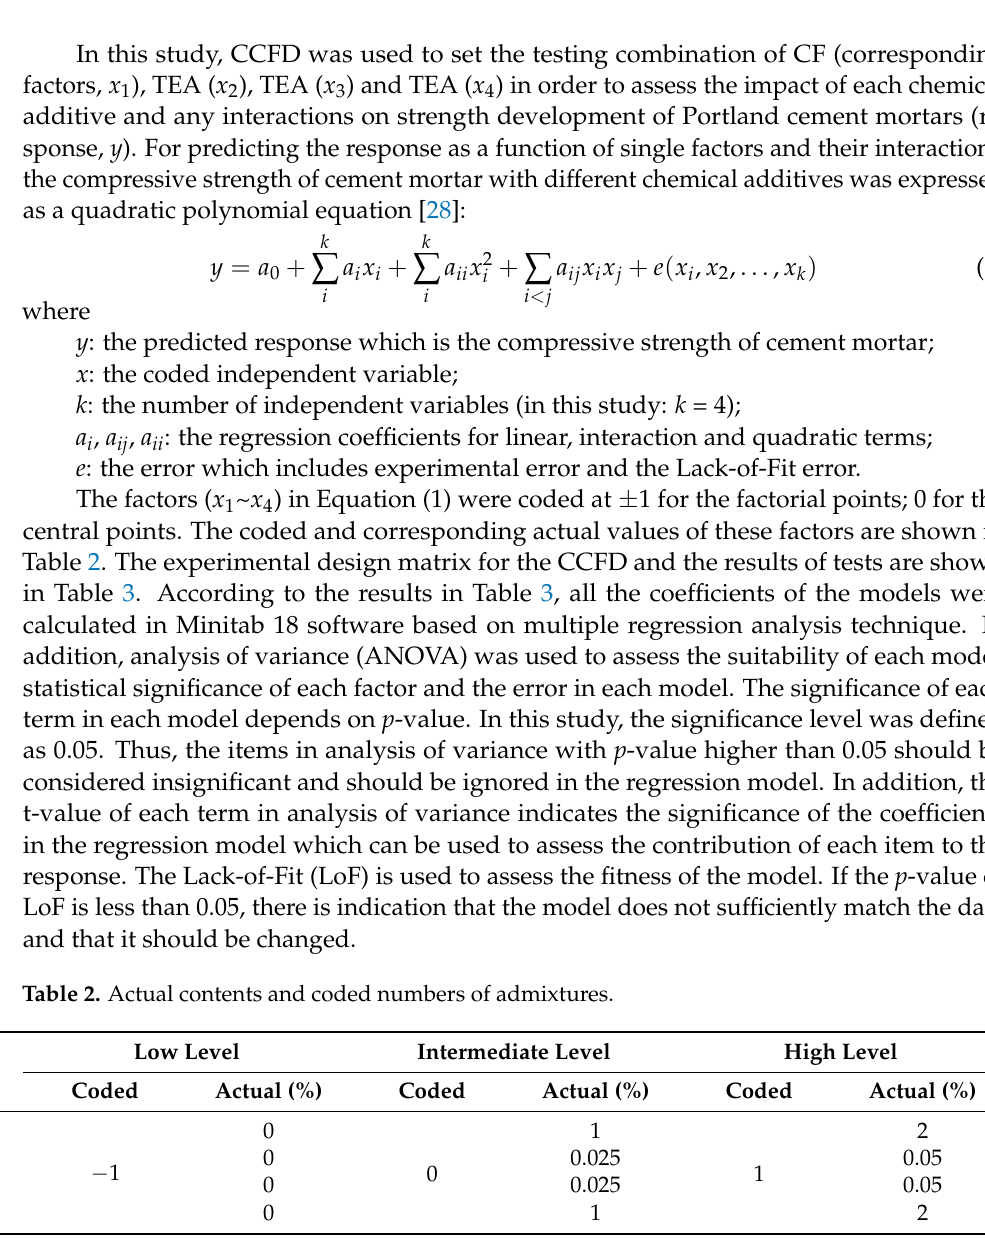
Table 3. The design matrix of CCFD and compressive strength of cement mortars. Chemical Additives (Coded